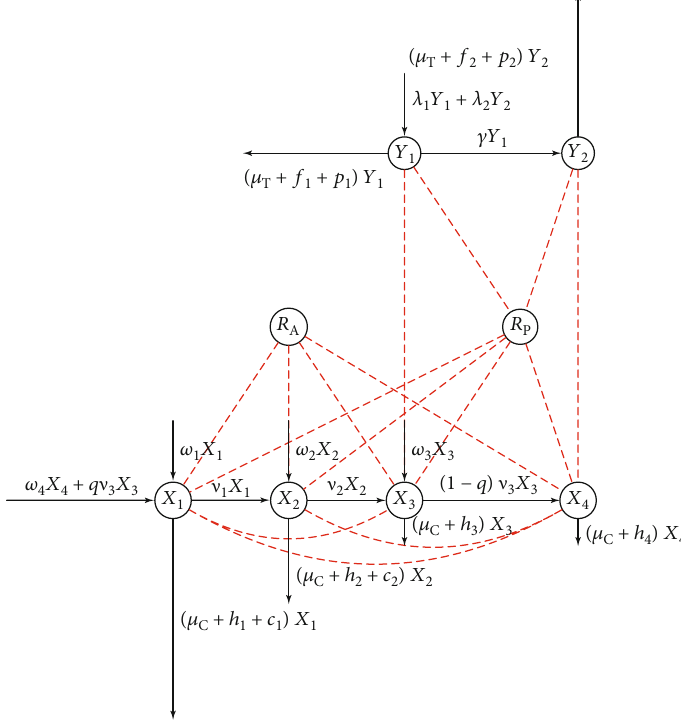
Figure 1: Schematic diagram of the dynamics of African cat fi sh, X growth, reproduction, mortality, and maturation from one stage to another whereas dashed connections show the fl ow of energy in the food- web. The remaining parameters in the graph are de fi ned through Equations (4) – (13) (Tables 1 and 3 – 5).